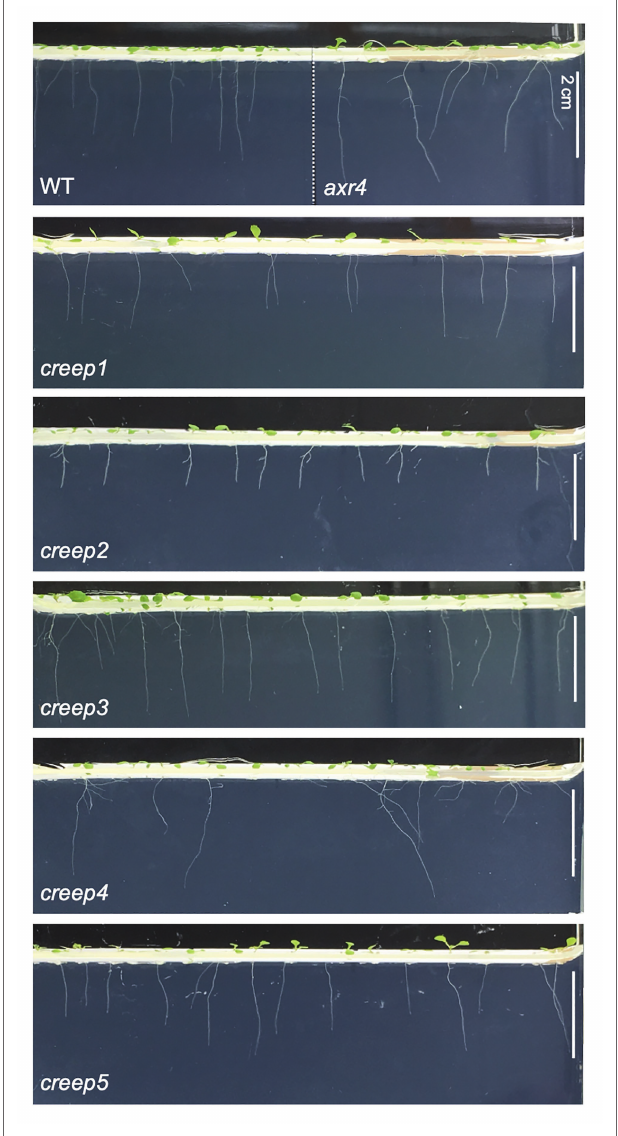
FIGURE 5 | The side view of creep mutants on ordinary, root-penetrable 1/2 MS-0.4% gellan gum medium. The seeds of each line were sown and incubated at 22 ° C. Wild type and axr4 plants were grown in the same growth chamber. Photographs were taken at 7 days after sowing. Scale bar = 2